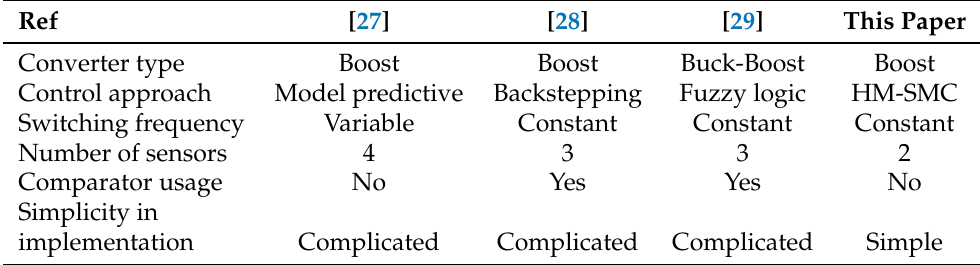
Table 4. Comparison of various control techniques with proposed control